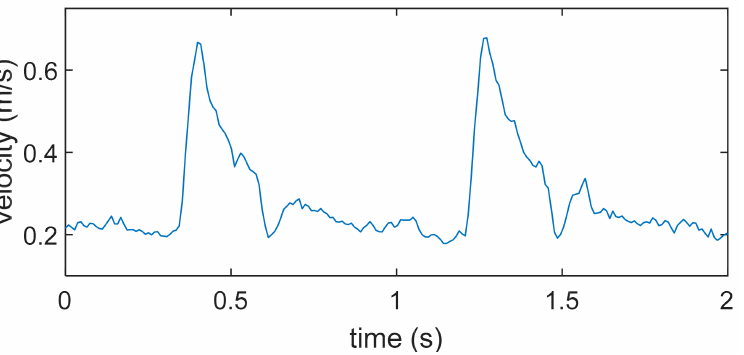
Figure 6. CCA blood velocity measured in one of the volunteers by the proposed method. The 2 s acquisition captured 2 systolic peaks, whose maximum was 0.67 m/s.